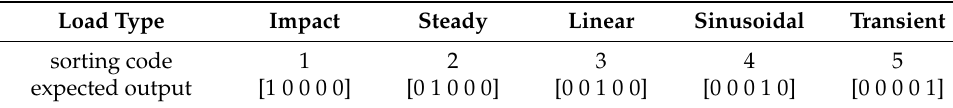
Table 4. Codes of five types of loads.